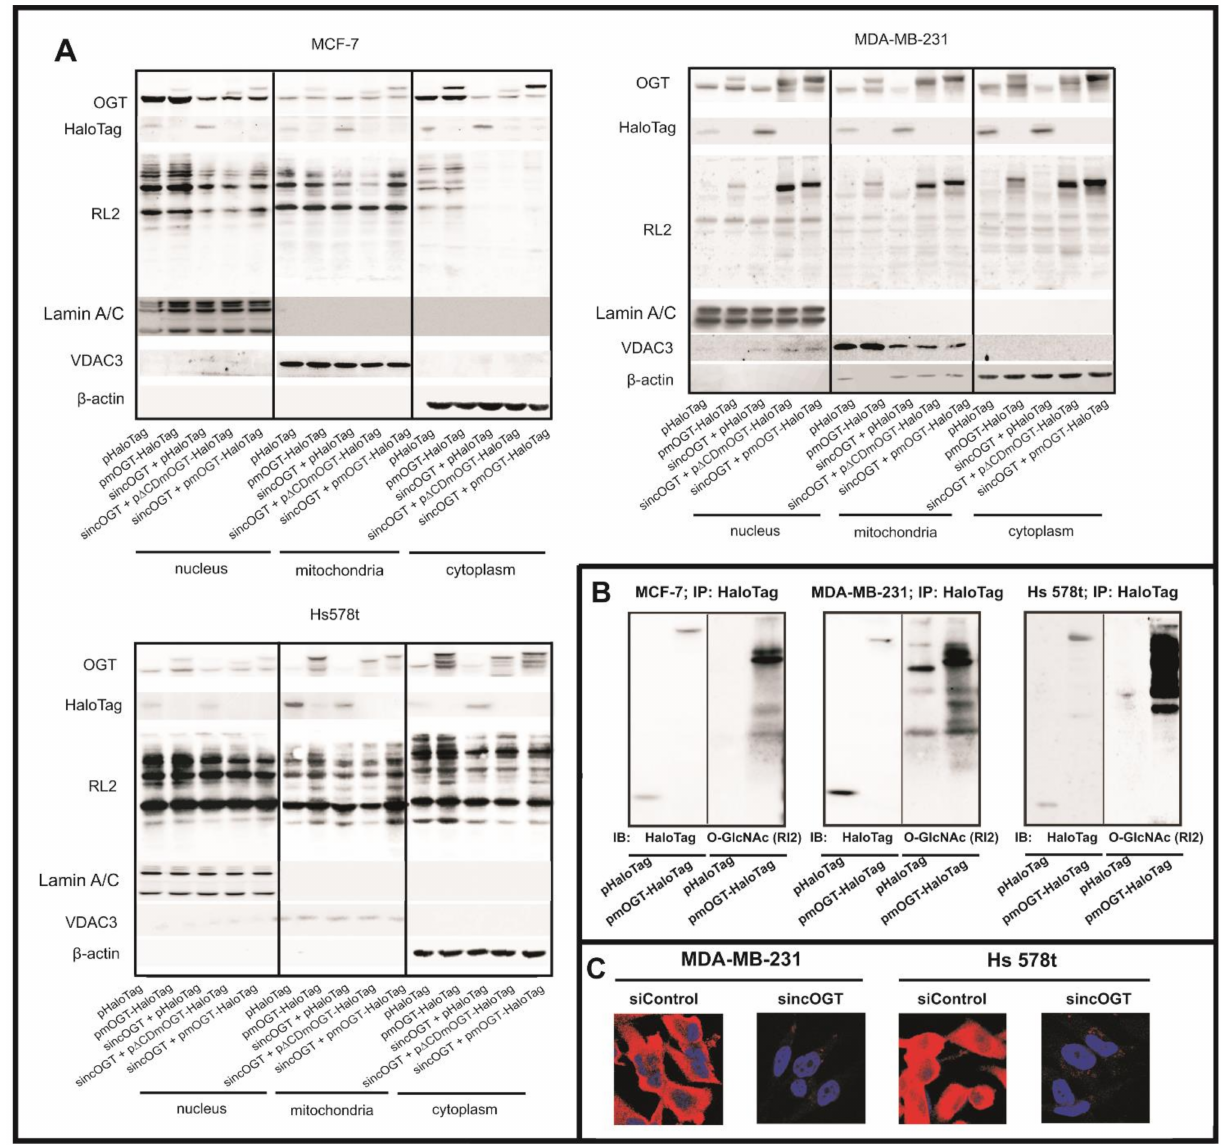
Figure 4. Isolation of mOGT candidate interacting proteins and modified substrates by proteomics approaches. ( A ) Repre- sentative Western blots present the effect of ncOGT knock-down and mOGT over-expression on the OGT and O -GlcNAc modified protein levels in nuclei- and mitochondria-enriched fractions and cytoplasm extracts from breast cancer cells. Blots were re-probed with Lamin A/C, VDAC3, and β -actin antibodies to verify the purity of isolated fractions. The mitochondrial lysates present herein were used for isolation of mOGT interactors or proteins modified by mOGT. ( B ) The confocal images of paraformaldehyde-fixed cells immunolabelled for OGT (red) counterstained with DAPI (blue) showing efficiency of ncOGT RNA interference. ( C ) mOGT-interacting proteins isolated from mitochondria-enriched lysates by using HaloLink Resin were probed with HaloTag and O -GlcNAc antibodies. (The original western blot images are shown in the File